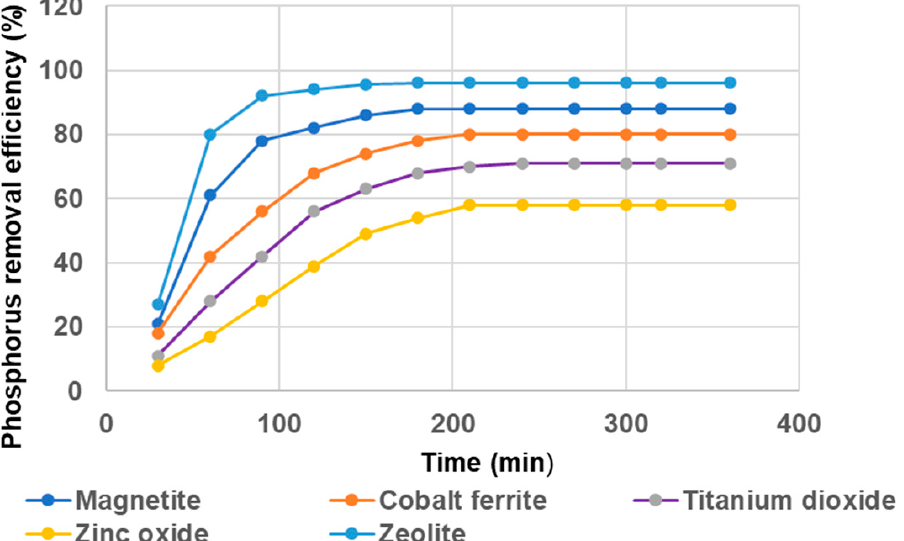
Figure 14. Effect of contact time on phosphorus adsorption efficiency .